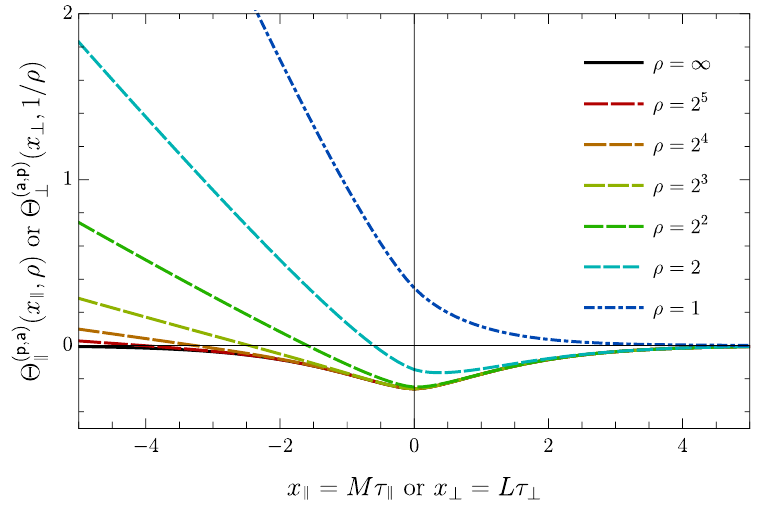
( p , a ) ( x ρ ) and due to the symmetry Θ ( a , p ) (cid:107) , (cid:107)